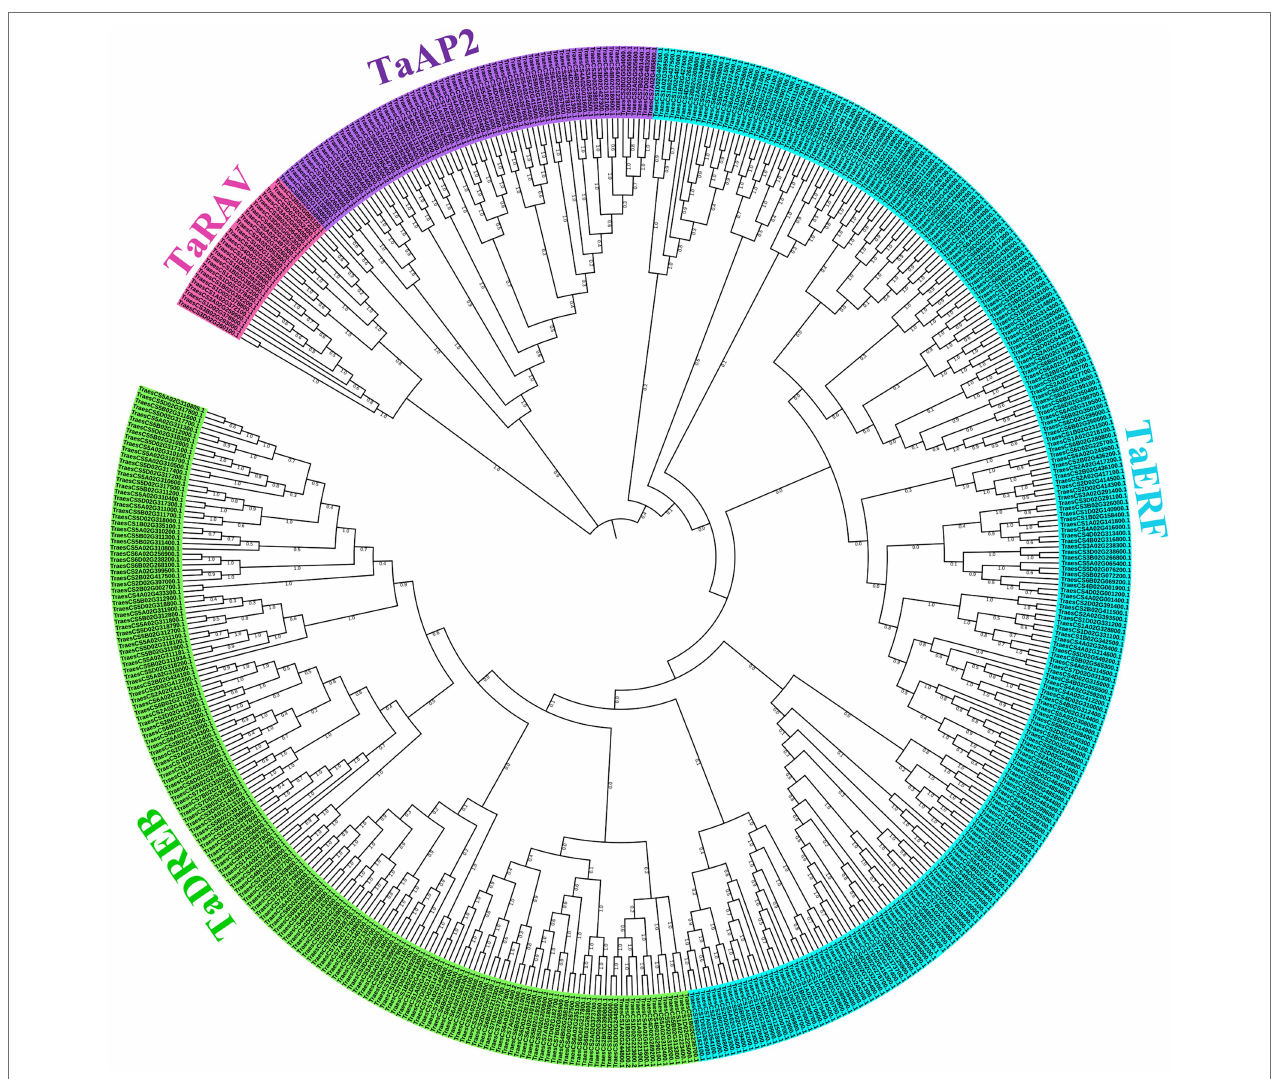
FIGURE 3 | Phylogenetic tree of 499 AP2/ERF TF genes in wheat. The unrooted neighbor-joining tree was constructed using a full-length protein sequence of 499 TaAP2/ERF TF genes in MEGAX software with a bootstrap test of 1,000 replications, which classified these genes into distinct four clusters: TaRAV family (26 TF genes in pink color), TaAP2 family (66 TF genes in purple color), TaERF sub-family (238 TF genes in light blue color), and TaDREB sub-family (169 TF genes in green